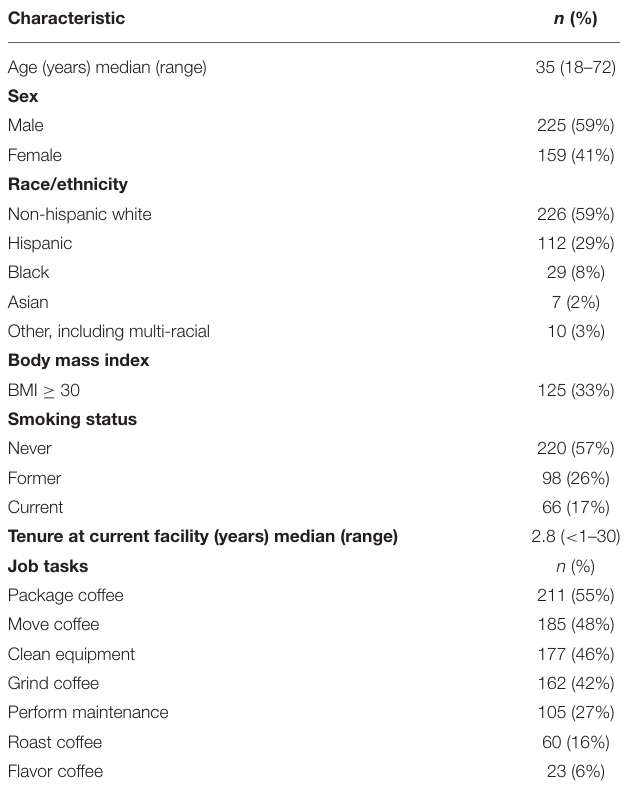
TABLE 1 | Characteristics and job tasks of participating workers in 17 coffee roasting and production facilities, N = 384.